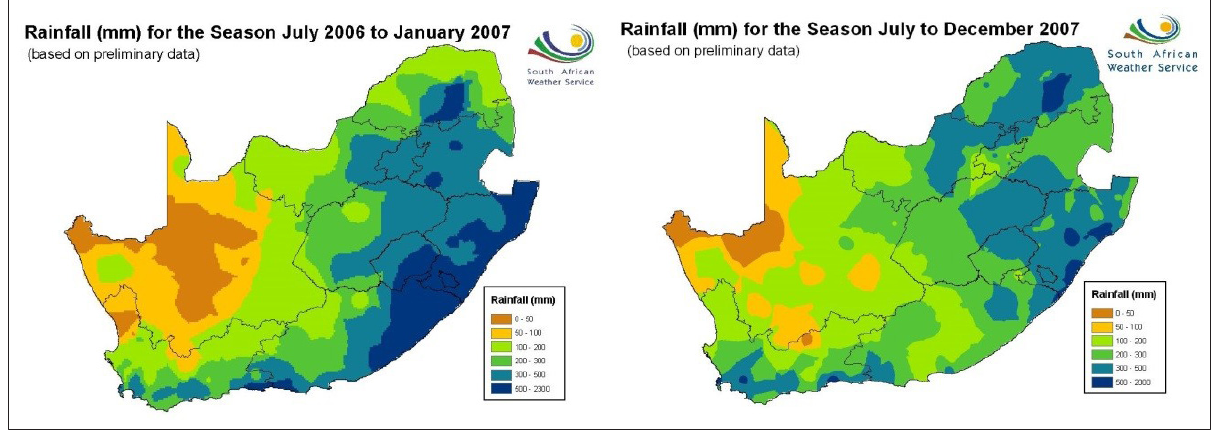
Charts courtesy of the South African Weather Service. Figure 5: Seasonal rainfall prior to and during the 2007 fire seasons with (a) indicating the high rainfall totals experienced between July 2006 and January 2007 and (b) showing the total rainfall experienced between July and December